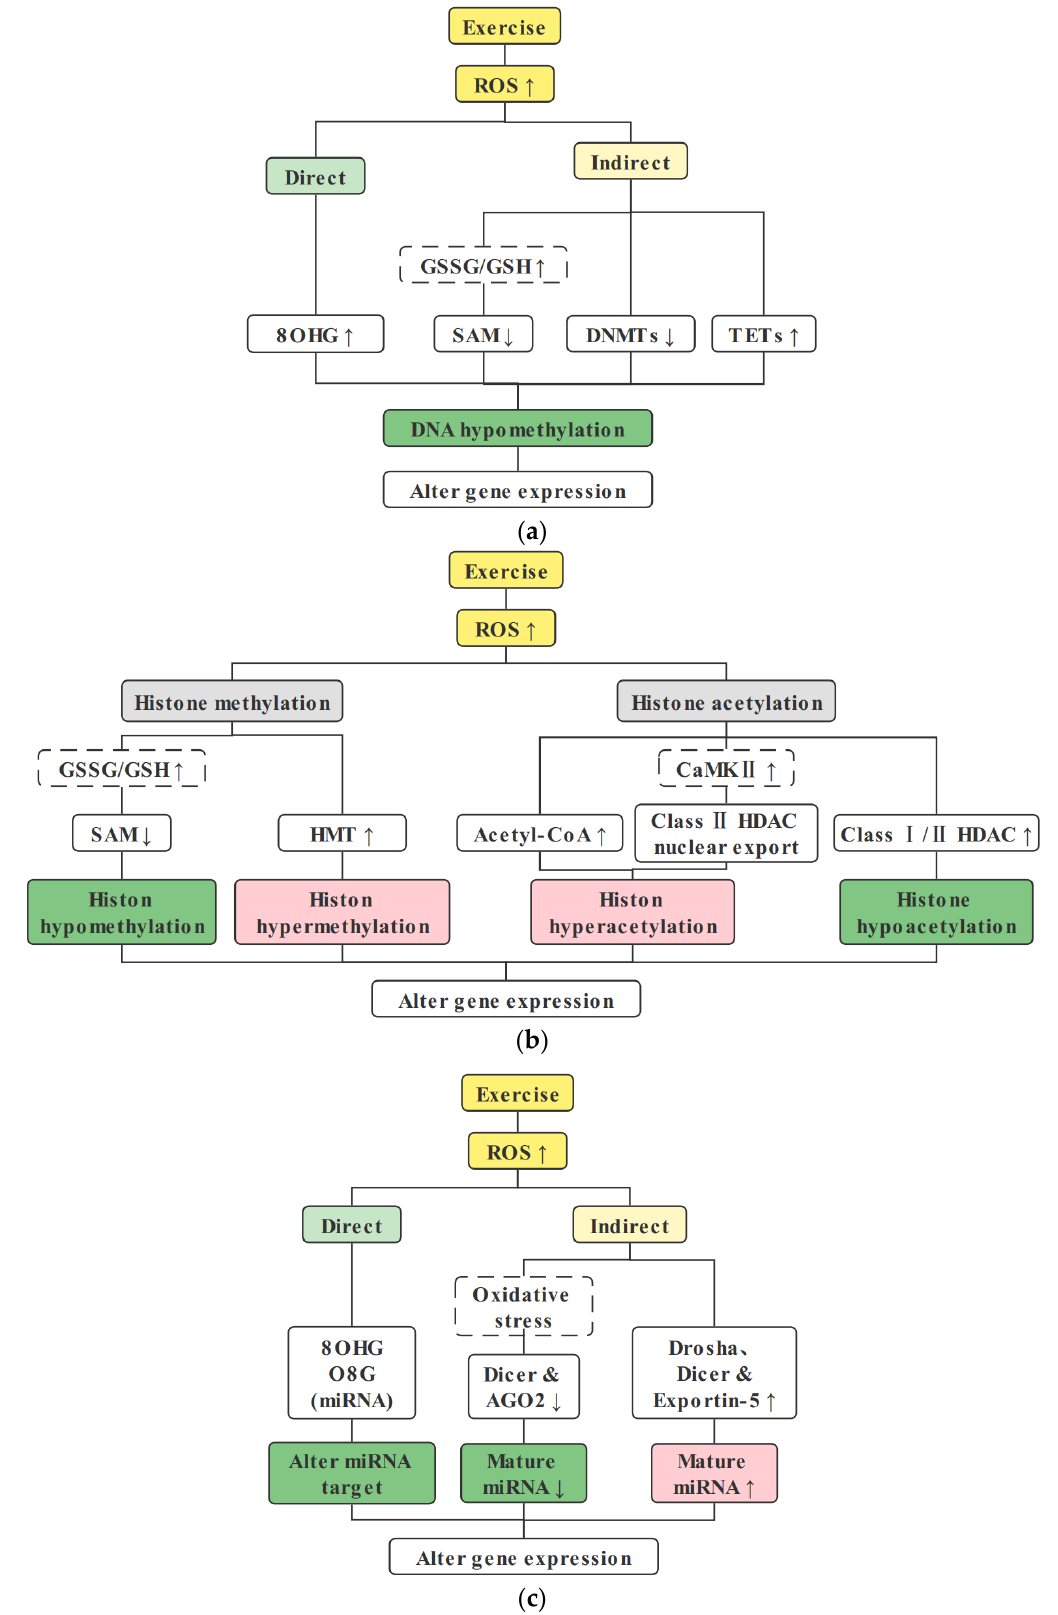
Figure 2. Exercise-induced ROS regulate epigenetic modifications. ( a ) Exercise-induced ROS down- regulate DNA methylation. ROS can directly inhibit DNA methylation via the formation of 8OHG; ROS can inhibit DNA methylation by downregulating the availability of SAM; ROS can also regu- late the activity and/or expression of DNMTs and TETs, inducing a decrease in DNA methylation. ( b ) Exercise-induced ROS can affect hPTMs. ROS can decrease histone methylation by downregu- lating SAM availability; ROS can increase histone methylation modification by upregulating HMTs; ROS can increase histone acetylation by upregulating acetyl-CoA availability or by inducing class II HDAC nuclear export through CaMKII; and ROS downregulate histone acetylation by upregu- lating class I/II HDACs. ( c ) Exercise-induced ROS regulate miRNA expression. ROS can directly oxidize miRNA and change the target mRNAs of miRNA; ROS can promote miRNA biogenesis by upregulating Drosha, Dicer, and extrotin-5; however, acute high-intensity exercise-induced ROS may cause oxidative stress and inhibit miRNA biogenesis by downregulating Dicer and AGO2. For abbreviations, see the list at the end of the paper. 5.1. ROS Are Necessary for Exercise-Induced Skeletal Muscle Health Benefits In the classic view, ROS act as a double-edged sword in cellular processes; excess ROS can cause oxidative stress, and physiological levels of ROS play an essential role in cell signaling [125–127]. Skeletal muscle ROS induced by regular exercise play an essential role in cellular signaling pathways that promote adaptive changes in skeletal muscle, such as increasing protein synthesis, activating insulin signaling, inducing mitochondrial bio- genesis, activating signaling pathways, controlling skeletal muscle production, affecting gene expression, and positively regulating antioxidants [128]. Although previous studies have suggested that antioxidant supplementation is beneficial for health, the current mainstream view is that antioxidant supplementation during exercise does not promote adaptive skeletal muscle changes but can even inhibit exercise-mediated health benefits. For example, Ristow et al. [129] demonstrated that exercise-induced ROS may play a role in promoting insulin sensitivity and antioxidant defense in humans by upregulating PGC- 1 α , PGC-1 β , SOD1, SOD2, and glutathione peroxidase 1. Daily intake of vitamins C and E almost completely eliminated the changes in the expression of these genes and the in- crease in insulin sensitivity after exercise [129]. Recently, Wang et al. [130] demonstrated that regular exercise could activate UPRmt and increase the content of SOD2. However, the expression of c-JUN, the C/EBP homologous protein, HSP60, CLpP, SIRT3, high-tem- perature-regulated A2 (also known as OMI), and SOD2 decreased after intervention with mitochondrial-derived ROS (mtROS) with the mitochondria-targeted antioxidant Mito- TEMPO. These results suggest that mtROS are a key factor for exercise to promote UPRmt. Thus, antioxidant supplements prevent many of the beneficial effects of exercise on me- tabolism. This evidence demonstrates that ROS are necessary for the exercise-induced health effects in skeletal muscle. We cannot deny that oxidative stress caused by